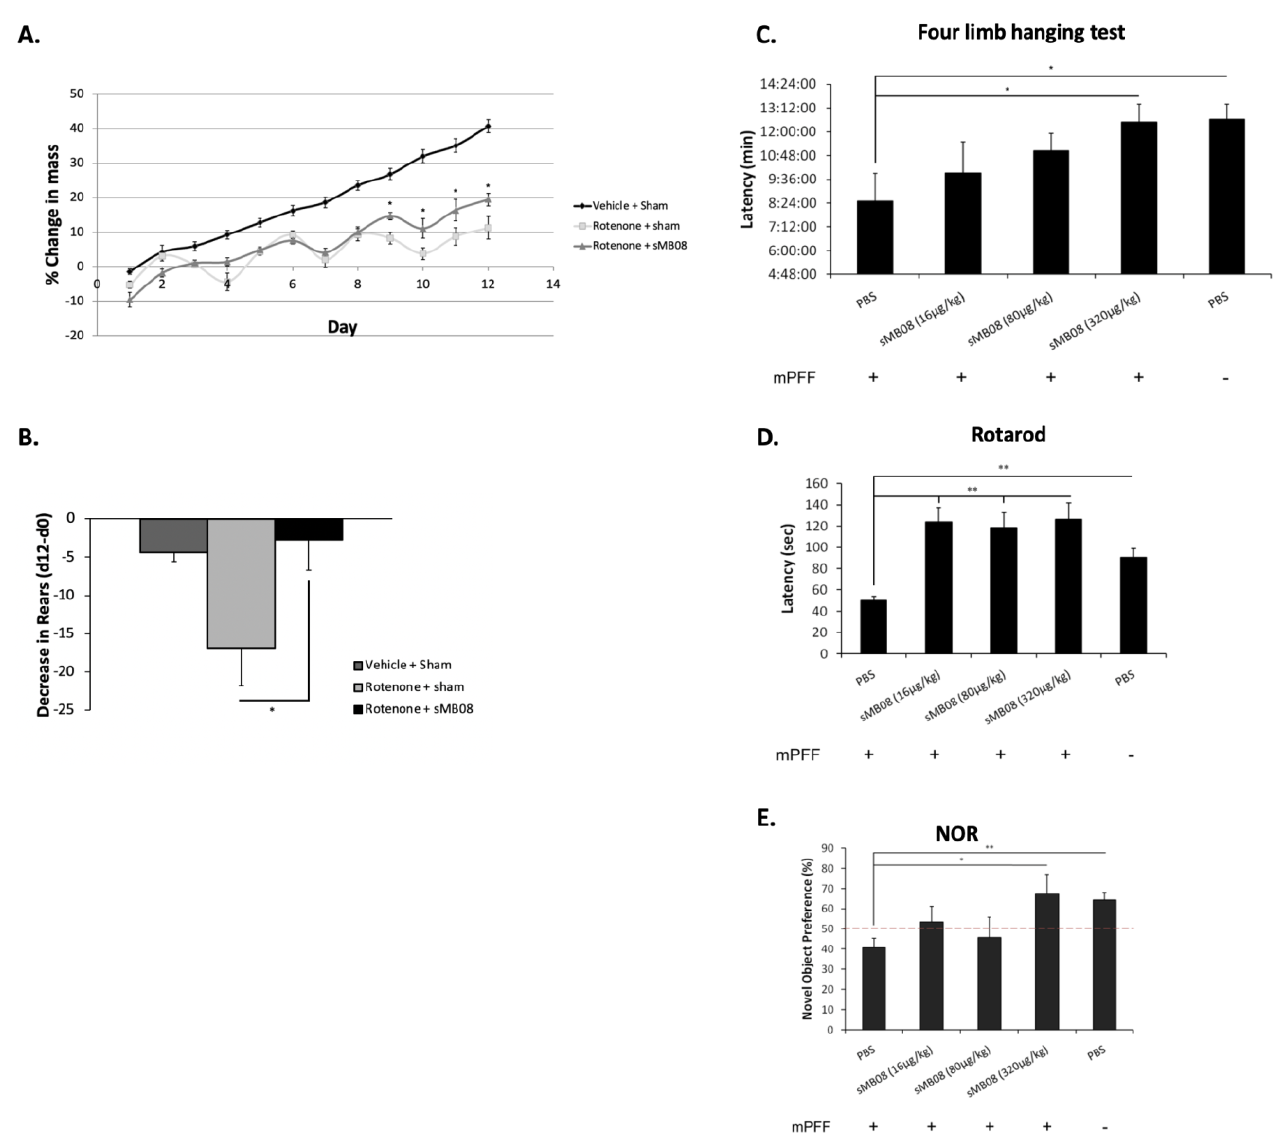
Figure 5. sMB08 treatment in the rotenone induced PD model. ( A ) Change of mass in rats injected with rotenone (Rotenone + Sham, n = 10), rotenone with sMB08 treatment (Rotenone + sMB08, n = 10), and control rats (Vehicle + Sham, n = 4). * p < 0.05. Error bars represent standard error of the mean. ( B ) Quantification of number of rears in rats. * p < 0.05. Error bars represent standard error of the mean. Mouse alpha-synuclein PFF induced PD. ( C ) Neuromuscular strength assessment using a wire hang test. * p < 0.05. Error bars represent standard error of the mean. ( D ) Rotarod test performed at 10 weeks after injection. ** p < 0.002. Error bars represent standard error of the mean. ( E ) Mean novel object preference for all mice groups during the testing phase when one familiar object and one novel object were presented to mice is shown. ** p < 0.002, * p < 0.05. Error bars represent standard error of the mean.